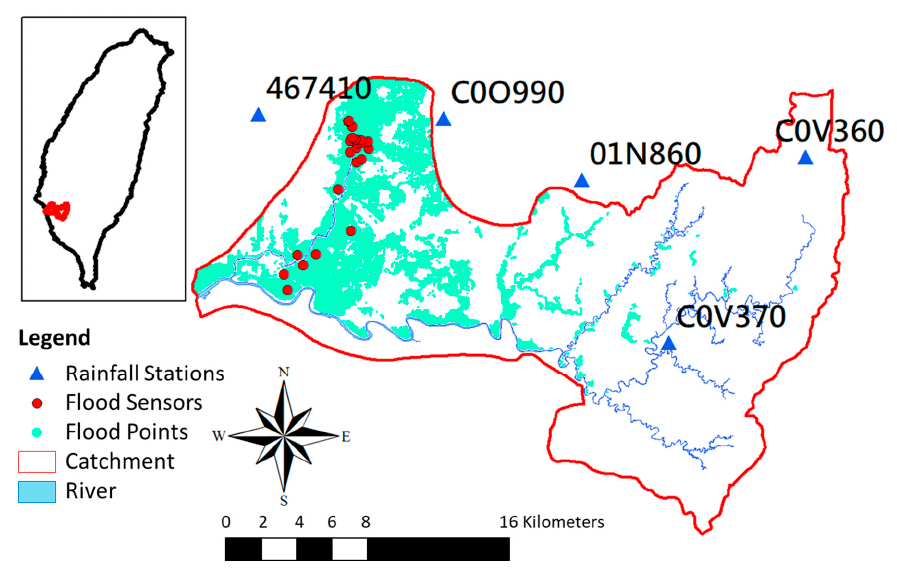
Figure 2. Study area of Erren river catchment. Table 1. Simulation events used for model training, validation, and testing.